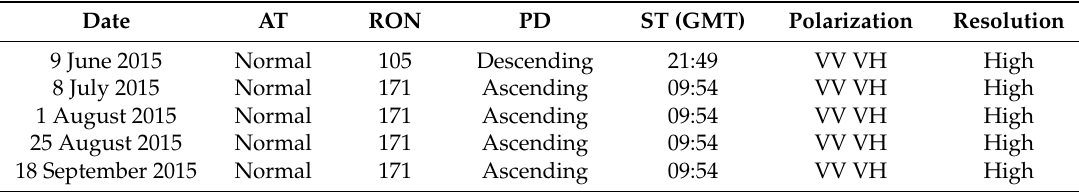
Table 1. Characteristics of Sentinel-1A level 1 GRD IW products used in this